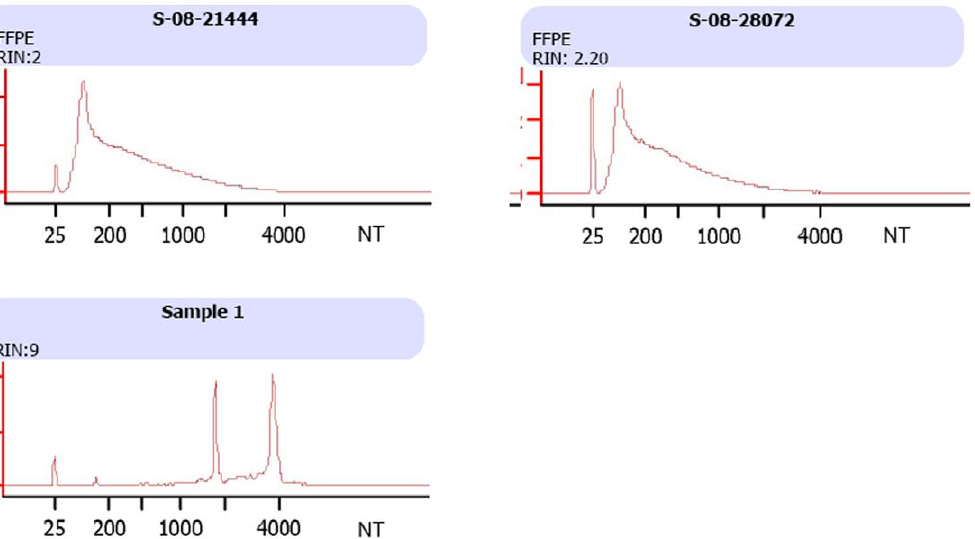
Figure 1. Bioanalyzer profiles of FFPE human peritumoral tissue total RNA. The total RNA was extracted from FFPE peritumoral tissues using Qiagen RNA extraction kit for FFPE samples or using Qiagen RNeasy Mini kit for human peripheral blood mononuclear cells (PBMCs). The upper panel shows the Bioanalyzer results of two FFPE RNA samples and the lower panel shows the profiling of RNA freshly extracted from human PBMCs. The Bioanalyzer profiles were obtained using Agilent RNA Nano LabChip.